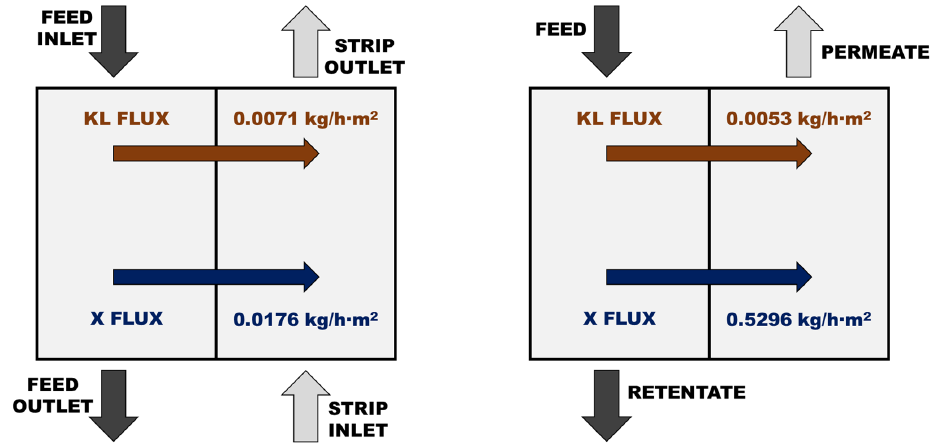
Figure 6. Comparison of the fluxes of Kraft lignin (KL) and xylose (X) through the SILM and the UF5 membrane.